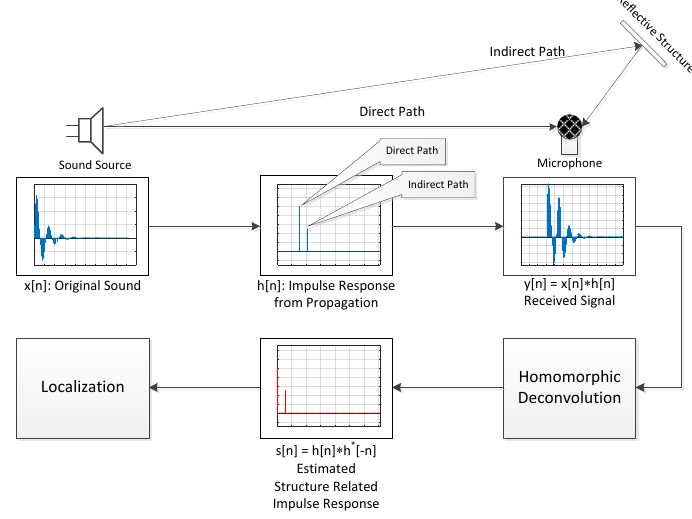
Figure 2. System architecture of the proposed RML system.